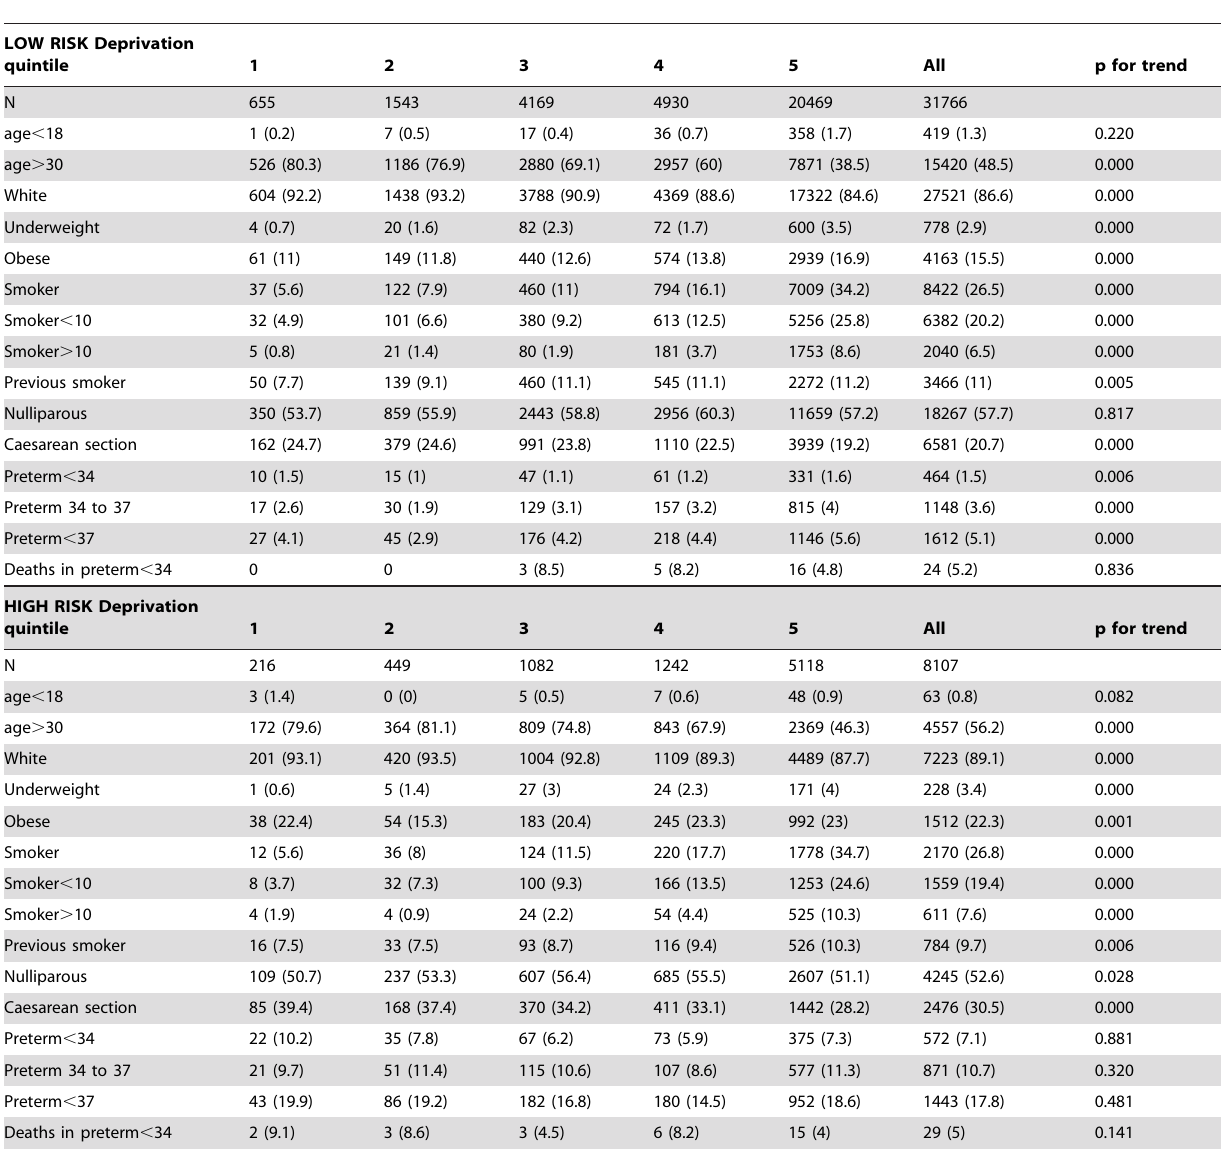
Table 1. Prevalence of risk factors and outcomes in low and high risk